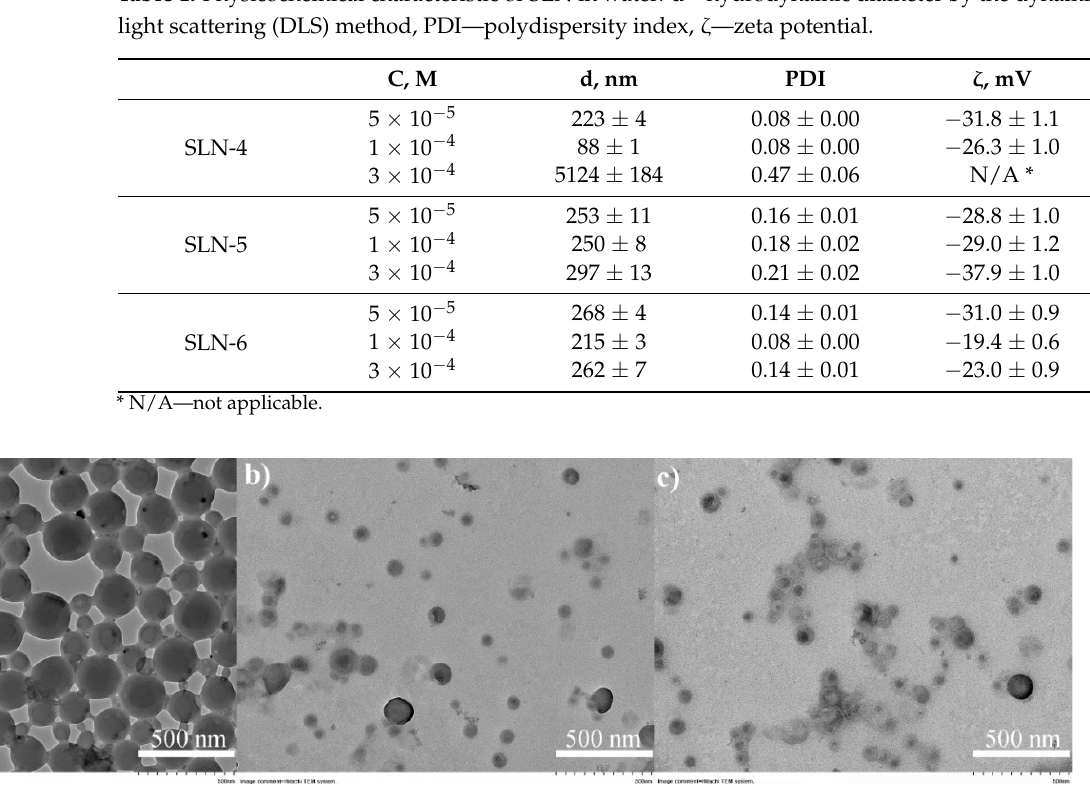
Figure 2. TEM images of: ( a ) SLN-4 (C = 5 × 10 − 5 M); ( b ) SLN-5 (C = 1 × 10 − 4 M); ( c ) SLN-6 (C = 1 × 10 − 4 M).